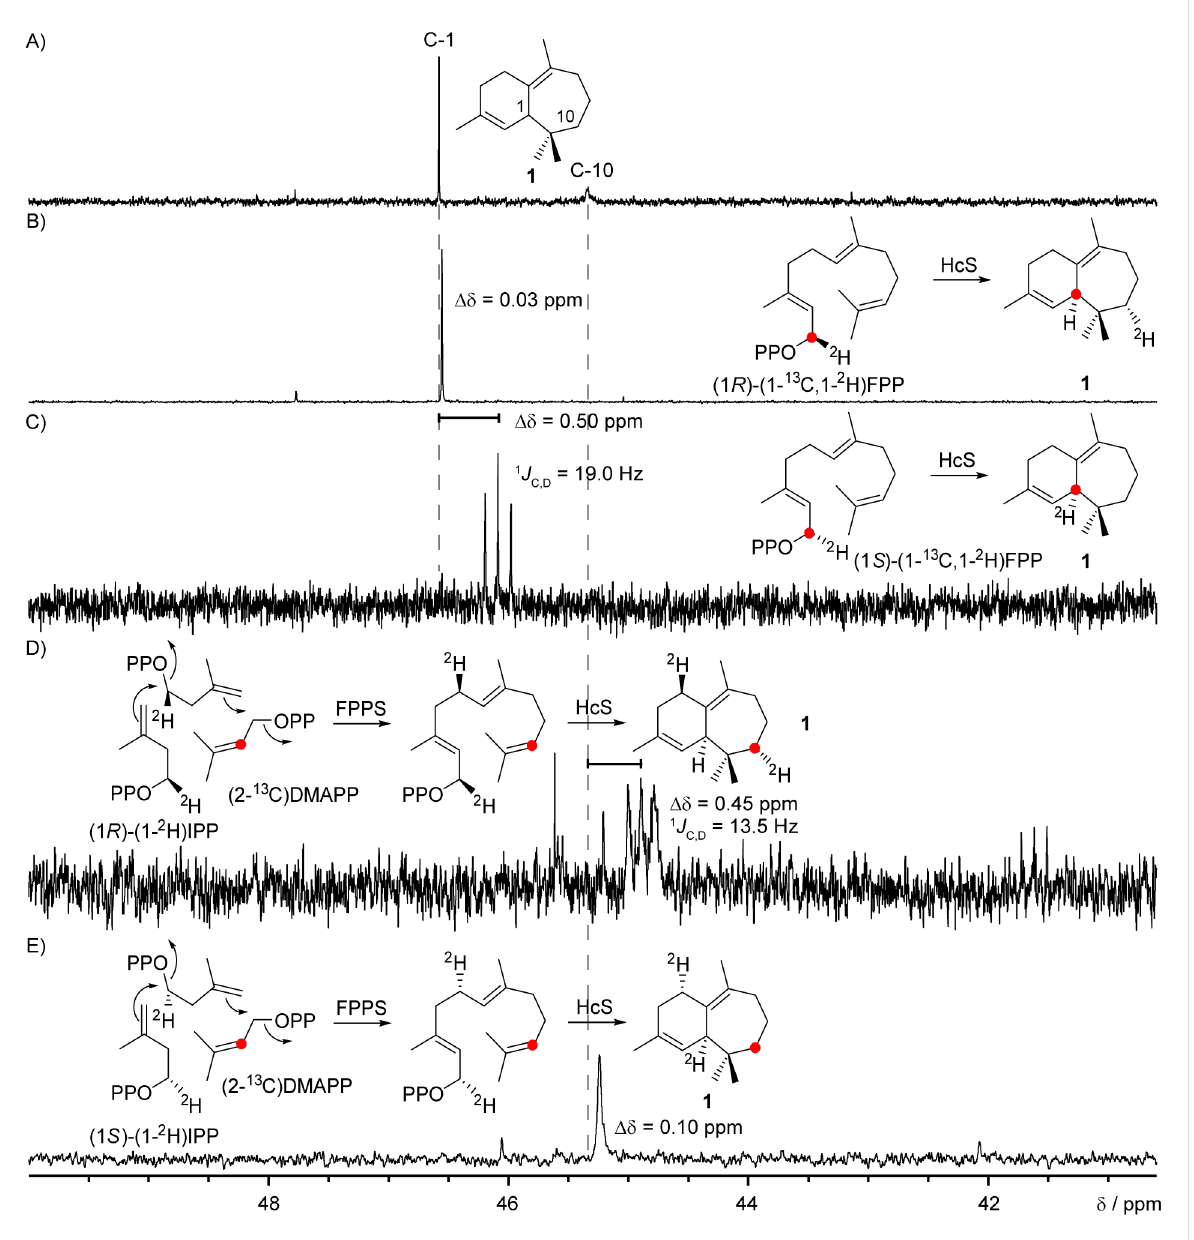
Figure 8: Investigation of the 1,3-hydride shift in the cyclisation towards 1 . Partial 13 C NMR spectra of A) unlabelled 1 , and incubations with HcS and B) (1 R )-(1- 13 C,1- 2 H)FPP or C) (1 S )-(1- 13 C,1- 2 H)FPP compared to incubations of HcS with FPPS, (2- 13 C)DMAPP and D) (1 R )-(1- 2 H)IPP or E) (1 S )- (1- 2 H)IPP showing a movement of H R from C-1 to C-10. The singlets for B) and E) are slightly shifted to higher field (designated as Δδ ) because of the deuterium location nearby. 13 C-Labelled carbon atoms are indicated by red dots. Dashed grey lines show the chemical shifts of the carbon atoms for unlabelled 1